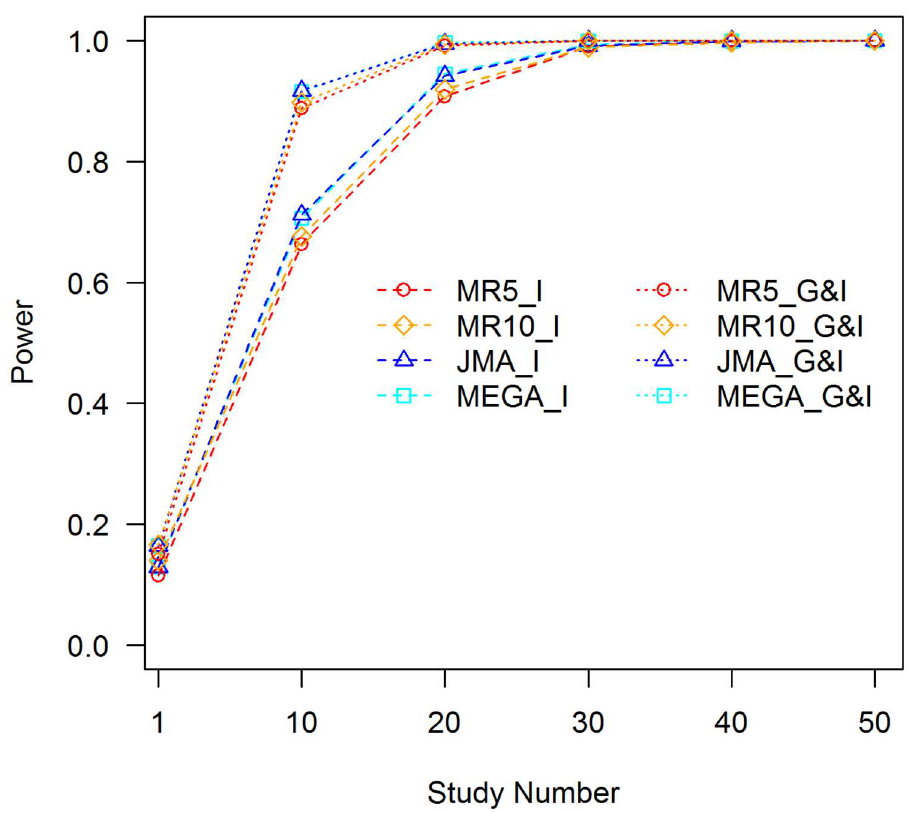
¼ 0 : 05% ; R 2 ¼ 0 : 05%. MR5_I: MR test of interaction Fig 6. Statistical power of tests of interaction, R 2 G I with 5 strata within each study; MR5_G&I: MR joint test of the geneticmain effect and interactionwith 5 strata within each study; MR10_I: MR test of interactionwith 10 strata within each study; MR10_G&I: MR joint test of the geneticmain effect and interaction with 10 strata within each study; JMA_I: JMA test of interaction; JMA_G&I: JMA joint test of the genetic main effect and interaction;and MEGA_I: mega-analysis test of interaction; and MEGA_G&I: mega-analysis joint test of the genetic main effect and interaction.